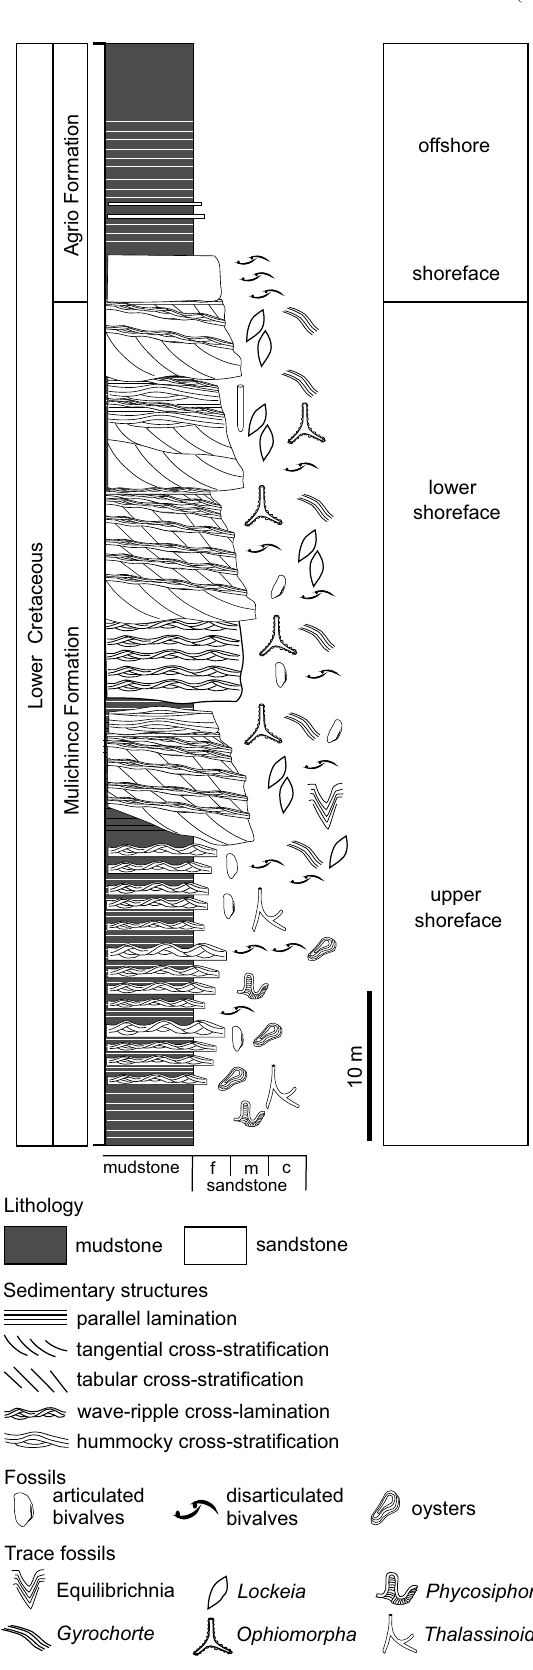
Fig. 2. Schematic section of the studied interval of the Mulichinco Formation exposed at Puerto Curaco locality. c, coarse; f, fine; m,